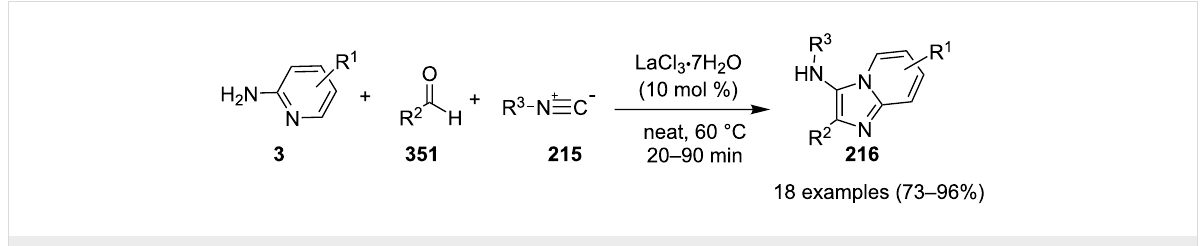
Scheme 116: La(III)-catalyzed one-pot GBB